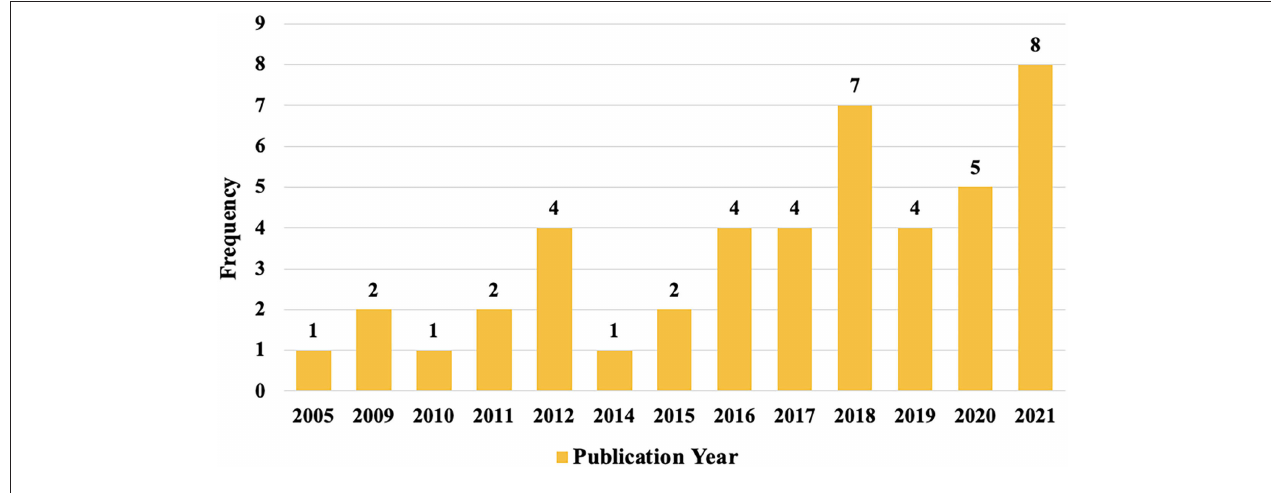
FIGURE 2 | A range of publication years of all articles.